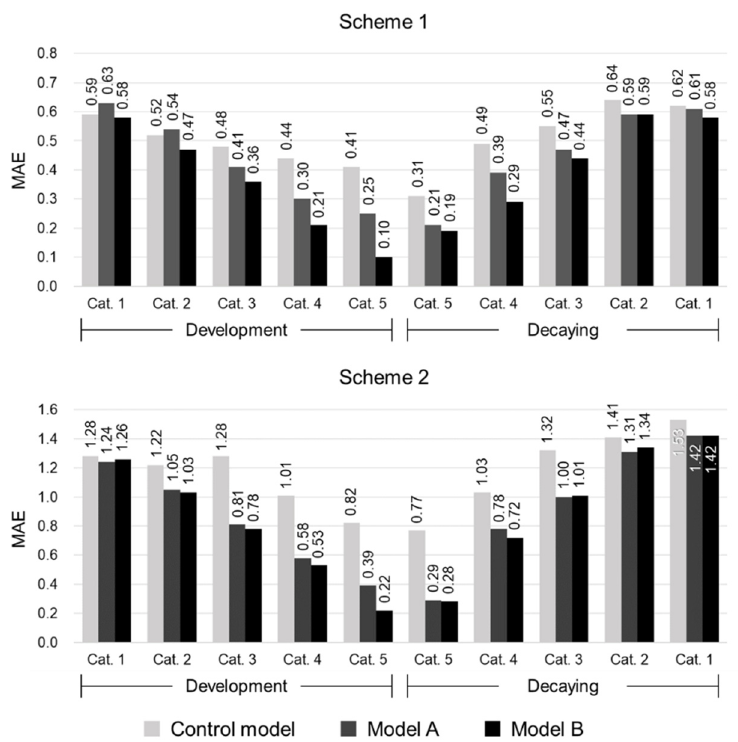
Figure 6. Mean absolute error (MAE) of the control model and models A and B for both scheme 1 ( above ) and 2 ( below ). The MAE of all models decreased as the tropical cyclone intensity increased. In both schemes, category 5 showed the best performance while category 1 yielded the largest estimation error.